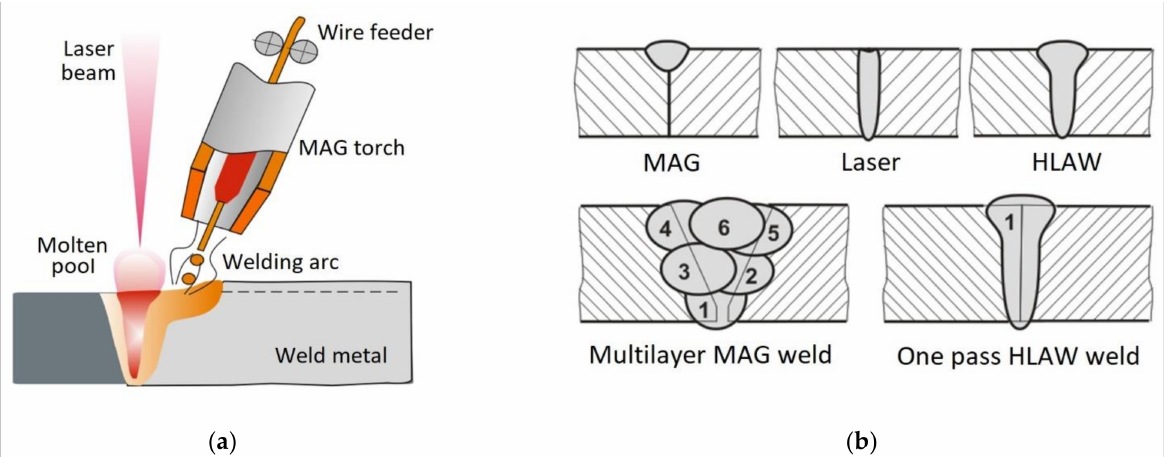
Figure 2. Hybrid laser arc welding (HLAW): ( a ) principle of the hybrid-welding process (laser–MAG Metal Active Gas ) and ( b ) differences between the shape and geometry of welds obtained using the MAG welding, laser welding, and laser–MAG welding process